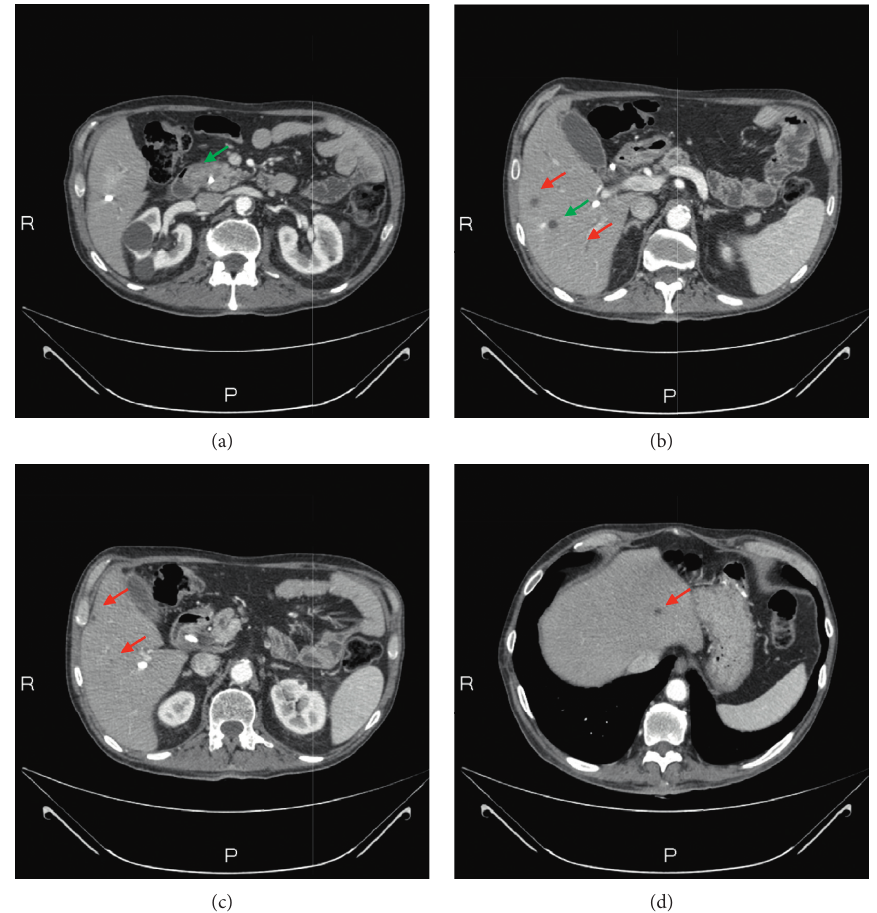
Figure 1: Staging: radiological evaluation of primary pancreatic lesion (a) and liver metastasis (b–d). The green arrows indicate the biopsied lesions and the red arrows indicate the liver